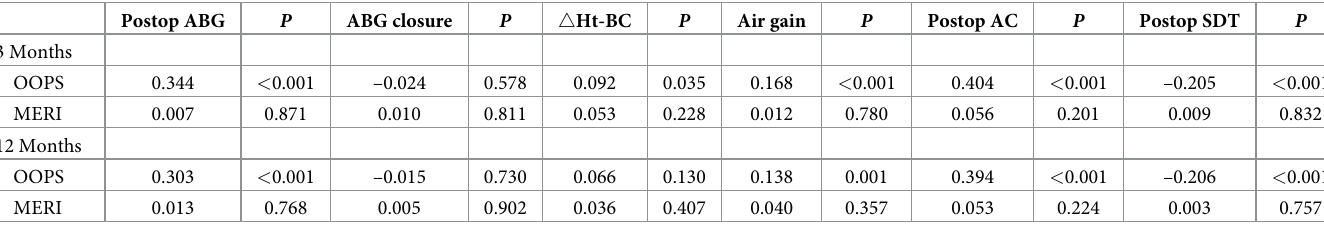
Table 2. Correlation coefficients between two indices and hearing